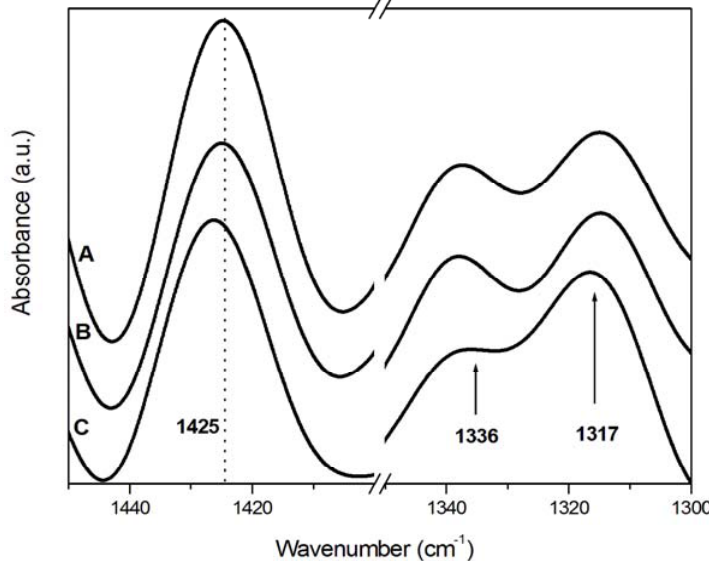
Figure 5. Deconvoluted FT-IR spectra of uncoated wood samples in the region 1300–1450 cm − 1 . ( A ) control; ( B ) sample exposed to natural weathering; ( C ) sample artificially